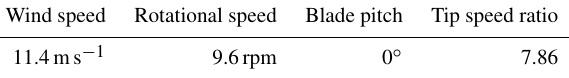
Figure 6. Influence of time step in 2-D, lift (no symbol) and drag (symbol (cid:52) ). Table 2. DTU 10MW turbine, rated operational conditions. Wind speed